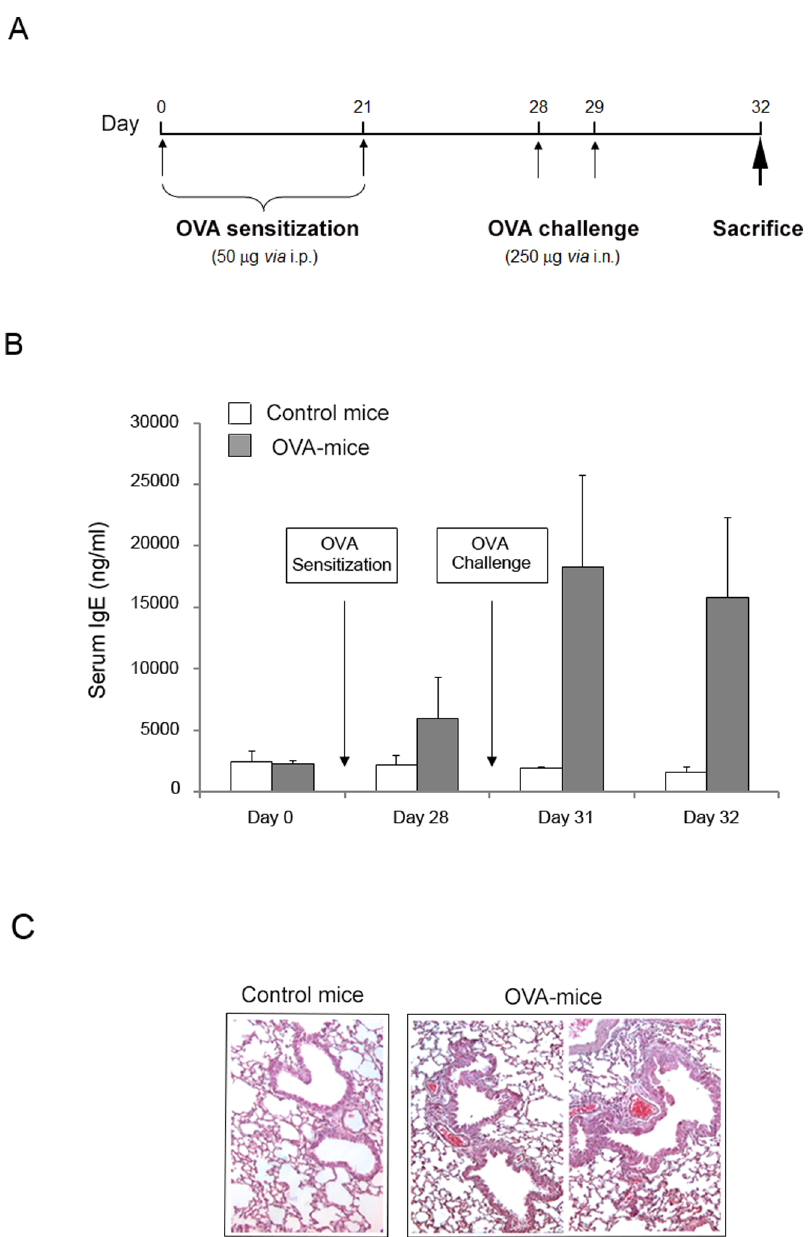
Fig. 2. Establishment of airway inflammation mouse model. Mice were exposed to an OVA ‘‘sensitization plus challenge’’ protocol. In A , the schedule and the timeline of OVA treatments of BALB/c mice are shown. In B , the circulating levels of total IgE were determined in serum samples of controls (n 5 16) and OVA-treated mice (n 5 16), harvested at the indicated experimental time points. Results are expressed as mean ¡ SD. In C , representative hematoxylin and eosin stained sections of lung tissue isolated (at day 32) from either healthy control or OVA-treated mice. Lungs of OVA-treated mice exhibit airway remodeling and thickness of epithelial cells (original magnification